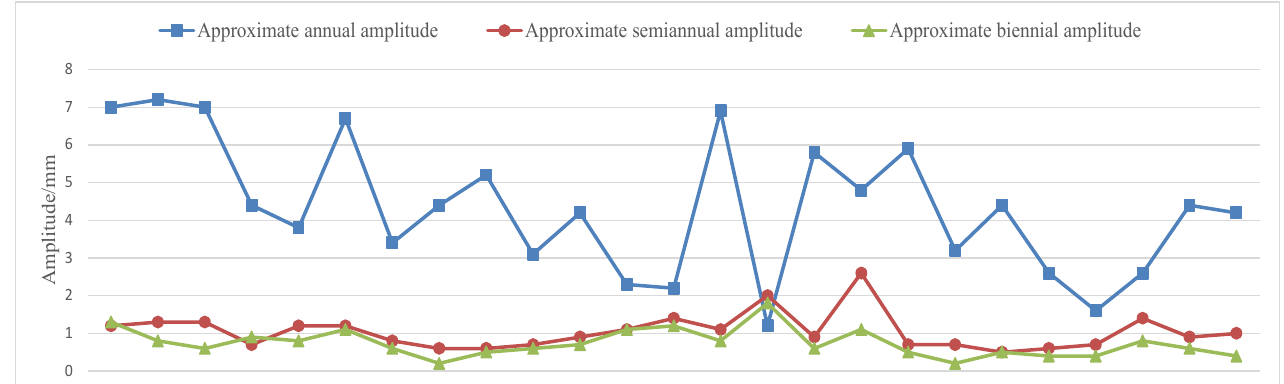
Figure 4. Amplitude value distribution (mm) of main periodic items of elevation nonlinear LS modeling of 25 CORS stations around the world.